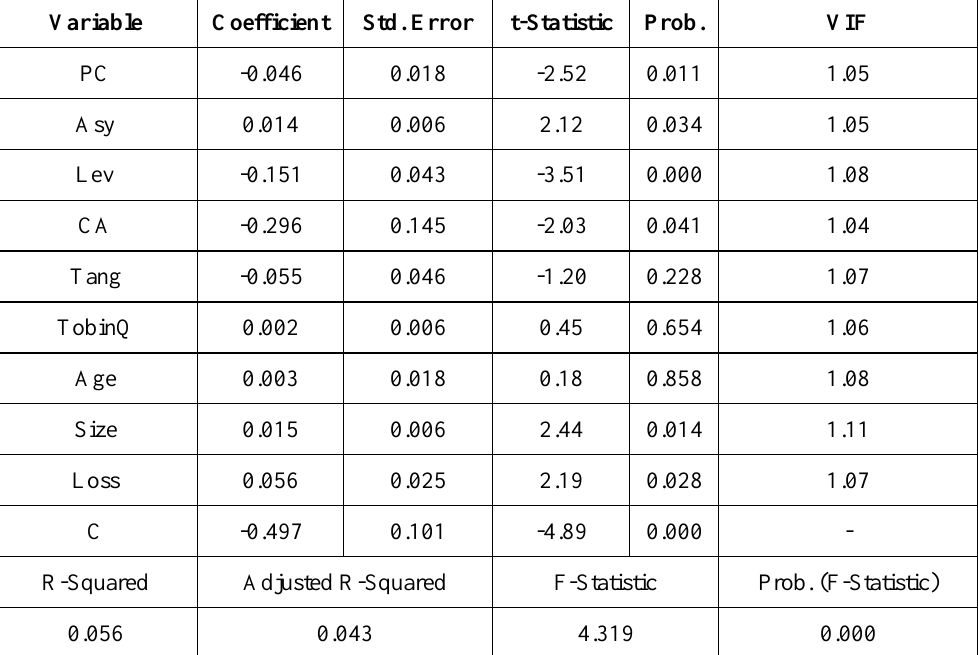
Table 5. Test results of the first and second